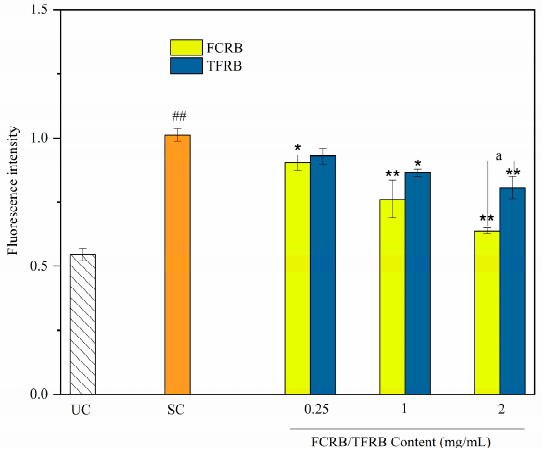
Figure 3. Effect of the FCRB or TFRB in H 2 O 2 -induced ROS generation in Caco-2 cells. The ROS levels were measured using the DCFH-DA probe. UC, untreated controls; SC, stress controls treated with 1 mM H 2 O 2 only. The results are presented as means ± SD ( n = 3). ## p < 0.01 vs. UC; * p < 0.05, ** p < 0.01 vs. SC; a p < 0.01 vs. TFRB (at the same concentration) as determined by using the one- tailed t test.